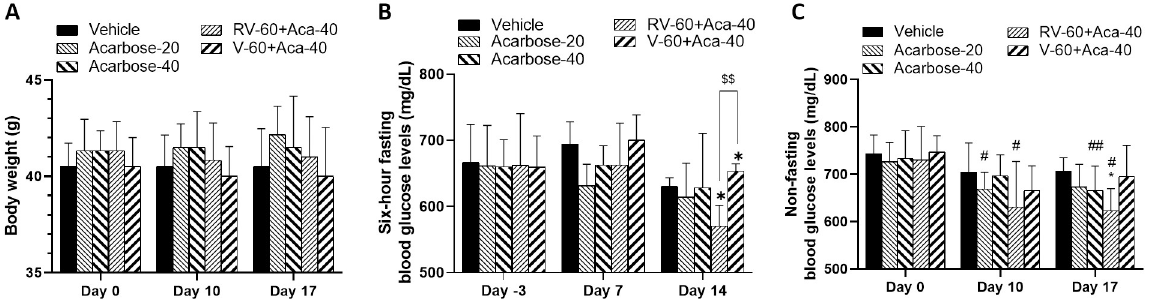
Fig 9. Effects of VA-combination, RVA-combination, and Acarbose-mono on db / db mouse body weight and BG. (A) Body weight changes (B) fasting BG levels (C) non-fasting BG levels. N = 6 in each group. � P < 0.05 indicates significant difference relative to vehicle; # P < 0.05 and ## P < 0.01 indicate significant difference from day 0 in same group; $$ P < 0.01 indicates significant differences among